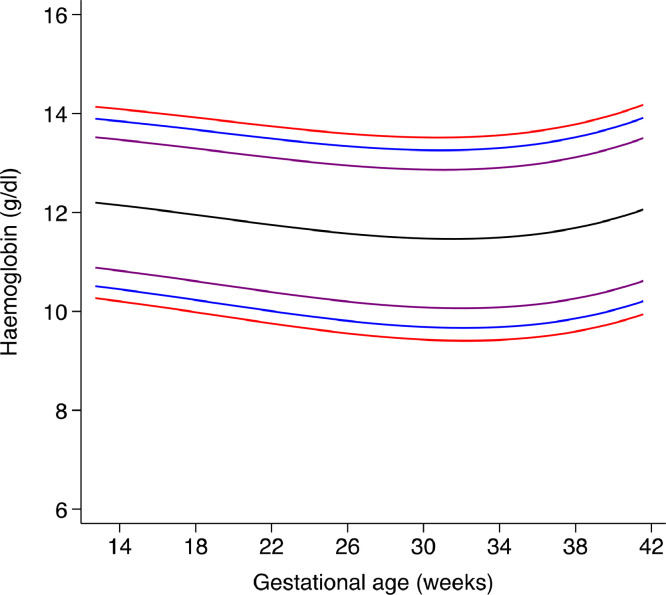
represents the smoothed, gestational age-specific, 3rd (red), 5th (blue), 10th (purple), 50th (black) 90th (purple), 95th (blue) and 97th (red) centiles for maternal haemoglobin. (For interpretation of the references to color in this figure legend, the reader is referred to the web version of this article.)